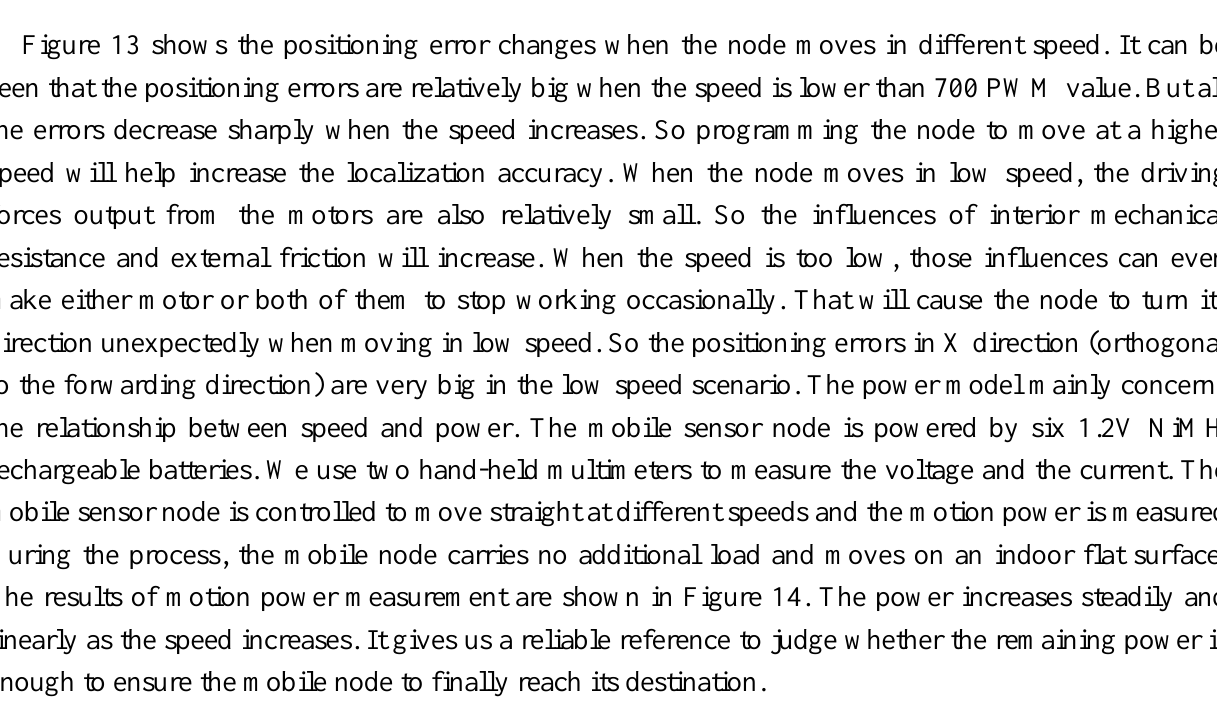
Figure 13. Positioning error changes when the node moves in different speed.